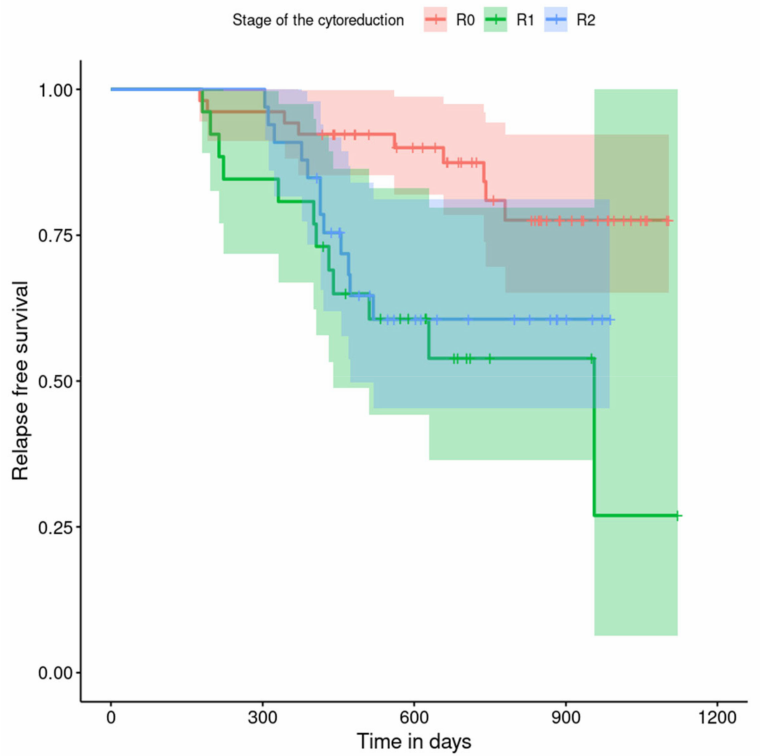
Figure 9. Relapse-free survival curve with 95% CI (darkened area) broken down by results of the